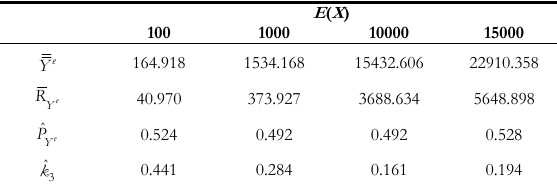
Sample estimates from r=50 simulated samples for